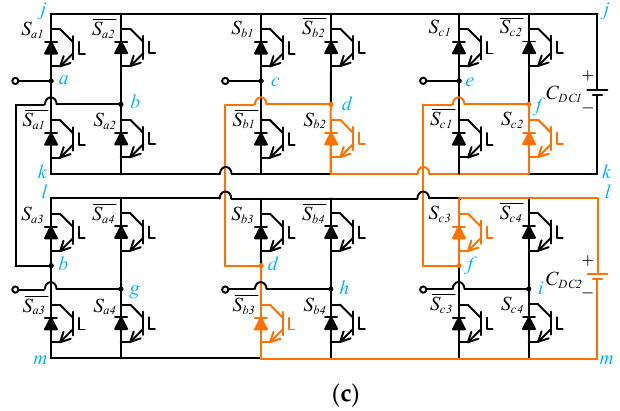
Figure 3. CHB-SDC short-circuit current path examples: ( a ) C DC 1 and C DC 2 in short-circuit [9]; ( b ) C DC 1 in short-circuit; ( c ) C DC 2 in